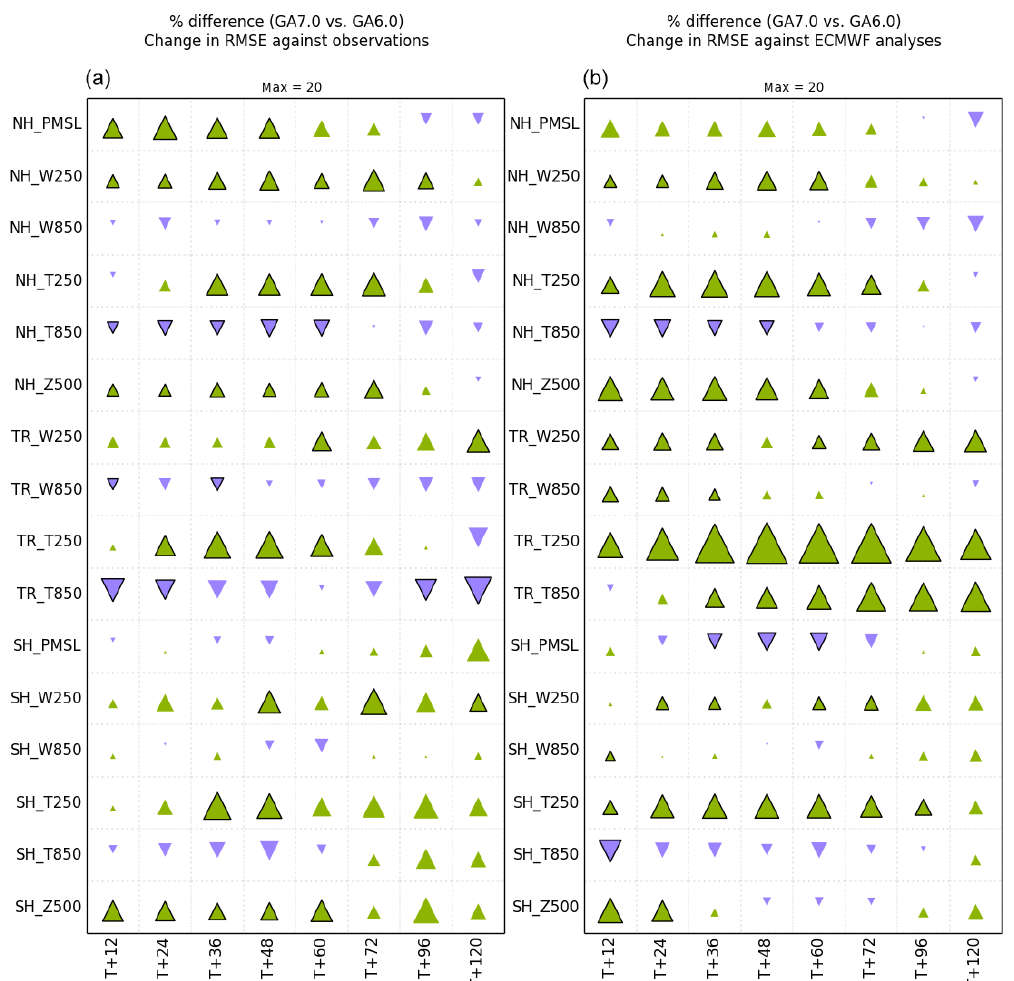
Figure 21. Percentage change in RMSE between GA7.0 and GA6.0 when verified against synoptic and radiosonde observations (a) and anal- yses (b) in a set of 24 N768 resolution forecast case studies run from operational ECMWF analyses. The rows represent RMSE differences for particular parameters in the Northern Hemisphere (NH), the tropics (TR) and the Southern Hemisphere (SH). The boundaries between these regions are at latitudes of ± 20 ◦ for verification vs. observations and ± 18 . 75 ◦ for verification vs analyses, which are calculated on a standard 2.5 ◦ grid. The parameters are pressure at mean sea level (PMSL), vector wind errors and temperature errors at 250 and 850hPa (W250, W850, T250 and T850) and geopotential height at 500hPa (Z500). The columns represent forecast ranges from 12h (T + 12) to 5days (T + 120). Green arrows pointing upwards represent a decrease in RMSE (i.e. an improvement), whilst purple down arrows represent a degradation. The area of the arrow denotes the size of the change with a 20% change filling the width of the column, and a solid outline denotes that the change is statistically